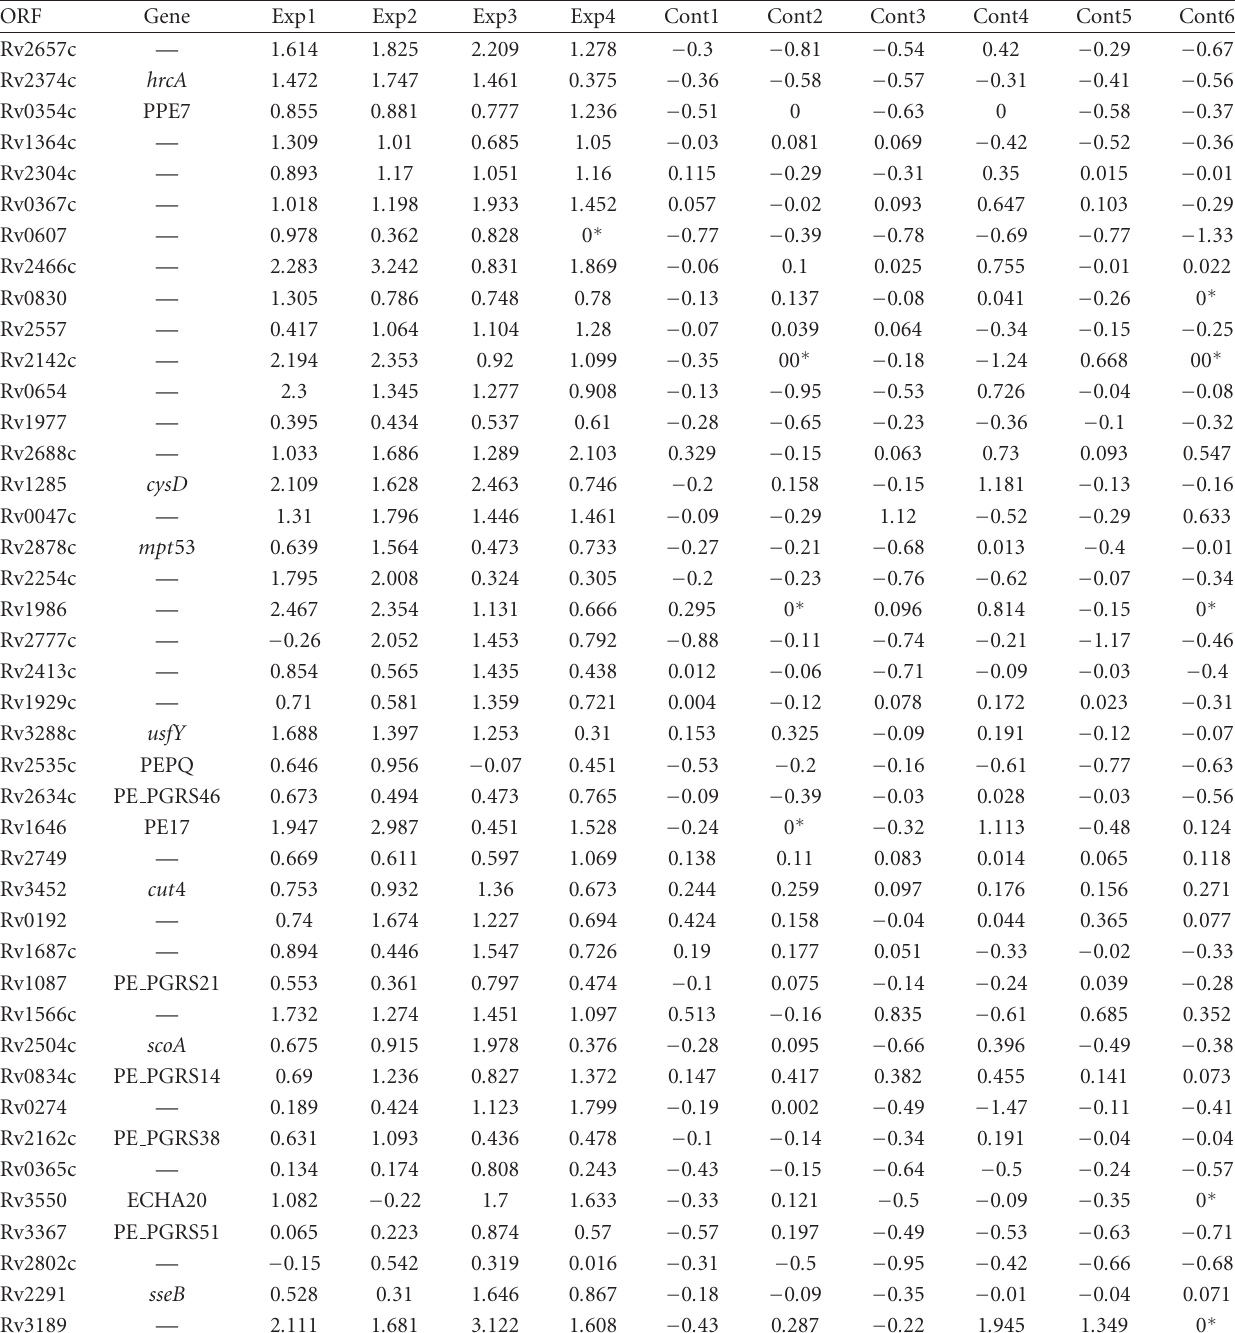
Table 2: The expression values (log 2 ratios) of genes more strongly induced by capreomycin and PA-824 than the other drugs. ORF Gene Rv2657c Rv0354c